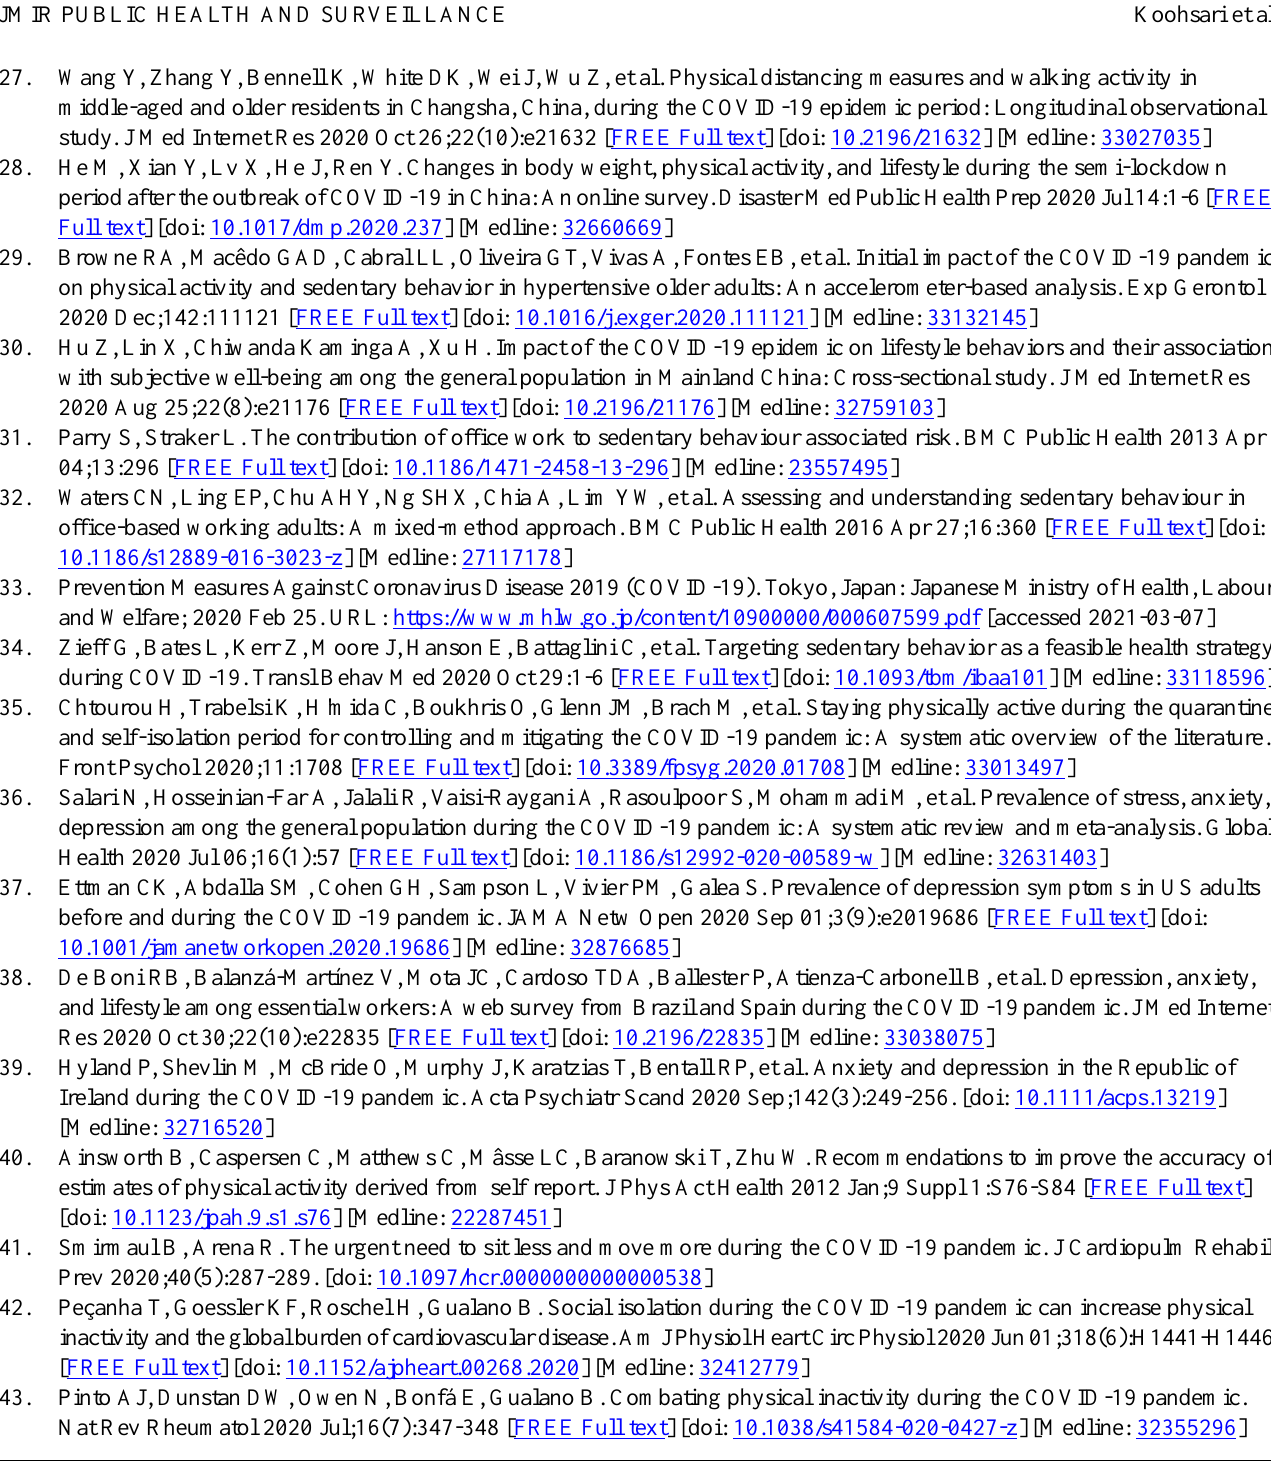
CIS20-R: Checklist Individual Strength questionnaire GPAQ: Global Physical Activity